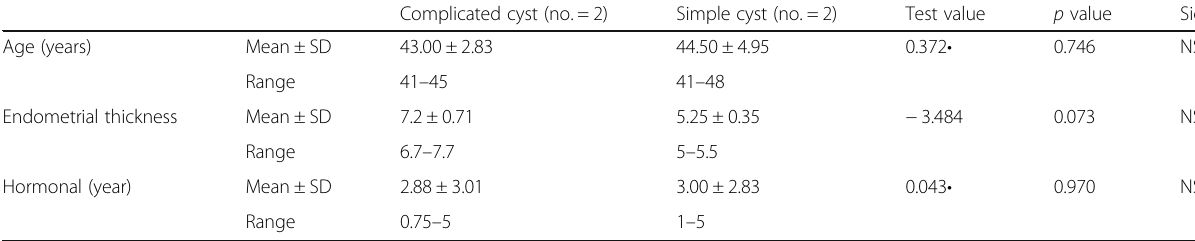
Table 5 Adnexal cysts with different variables